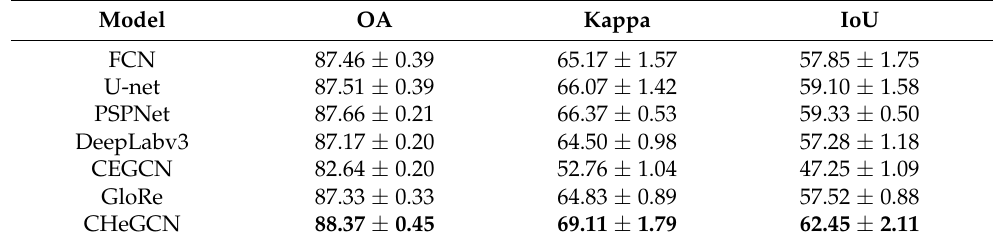
Table 4. Quantitative comparison of different methods in the Shenzhen dataset.